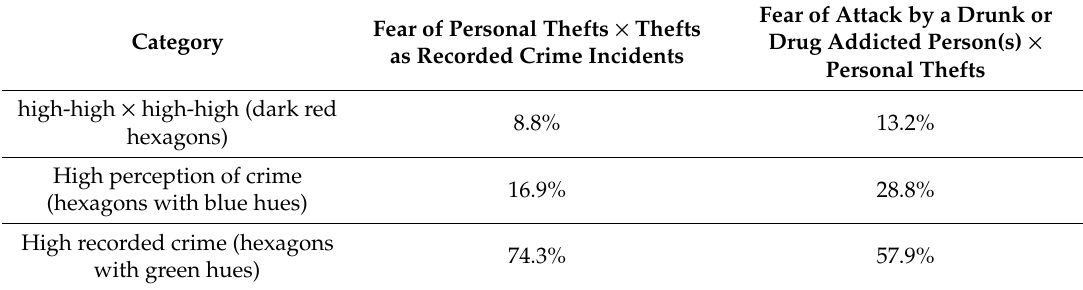
Table 4. Percentage of hexagons in three